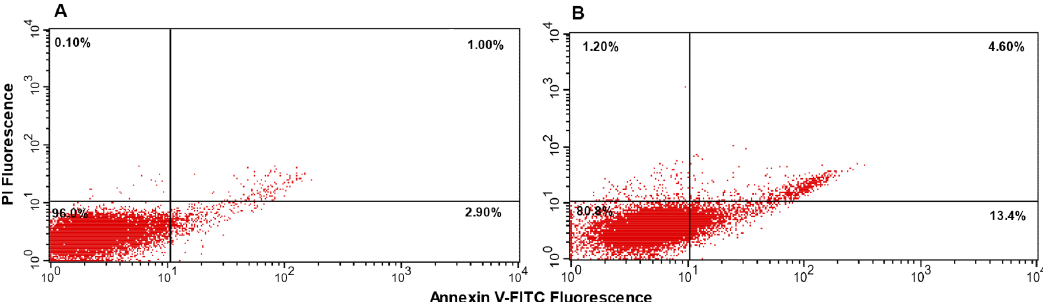
Figure 5. Apoptosis analysis with annexin V-FITC and propidium iodine ( PI) double staining on HeLa cells. HeLa cells were seeded at 40,000 cells/well on a 6-well plate and treated with 50 μM of complex 6 for 72 h. Panel A : control (vehicle treated cells); Panel B : cells treated with the complex 6 . Lower left quadrant: viable cells; upper left: necrotic cells; upper right: advanced apoptotic cells; low right: early apoptotic cells. These pictures are representative of two independent experiments.